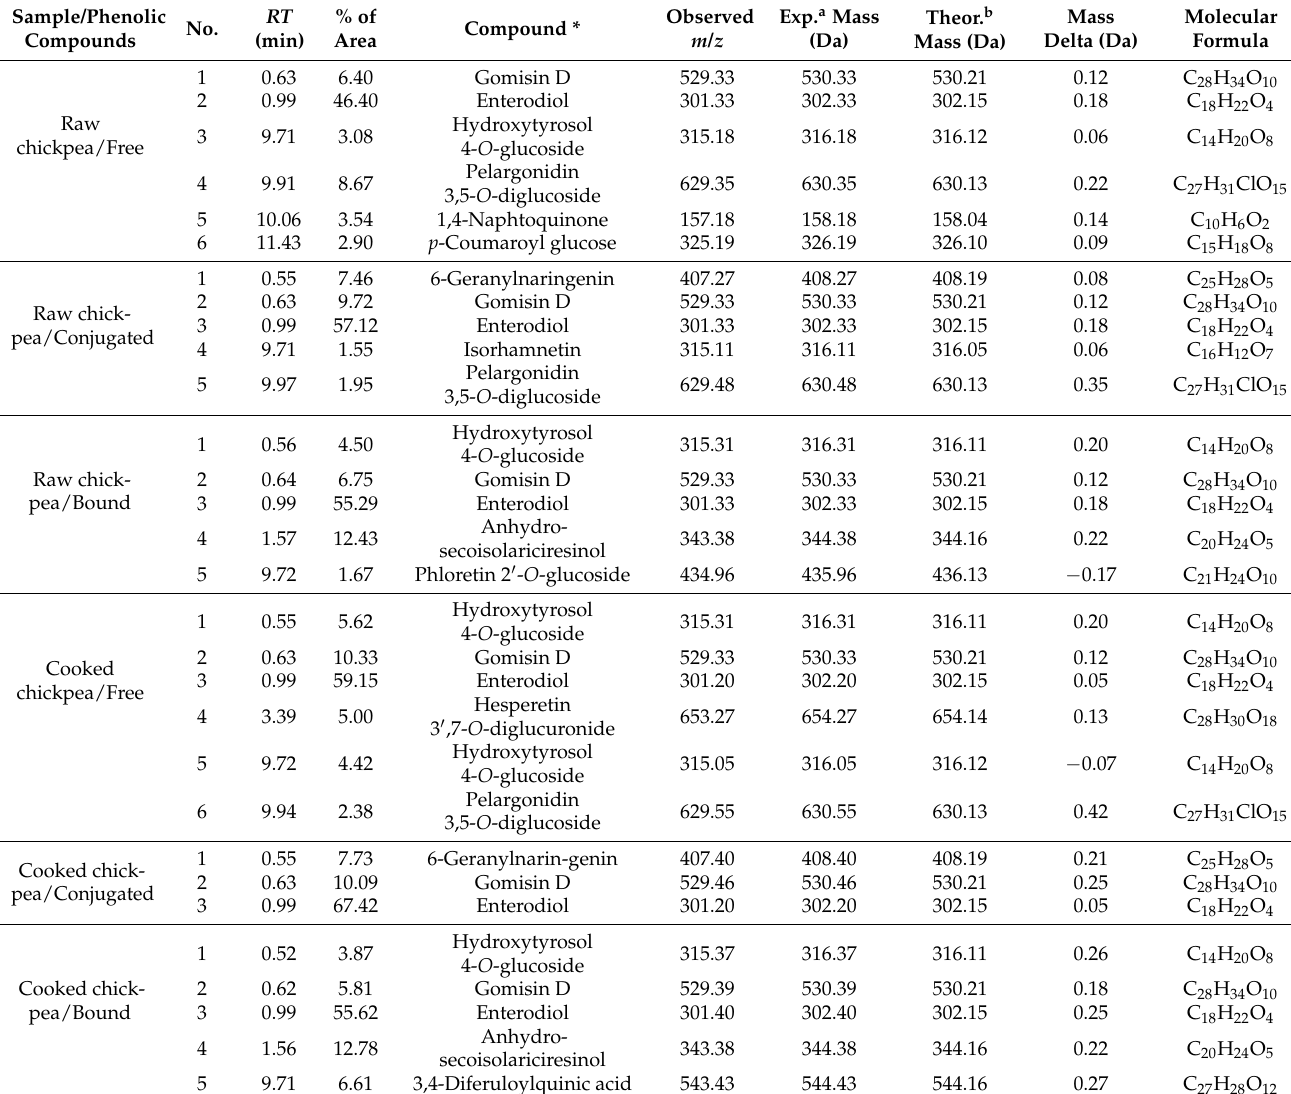
Table 5. Free, conjugated and bound phenolic compounds identified by UPLC-MS from raw and cooked chickpea. Sample/Phenolic